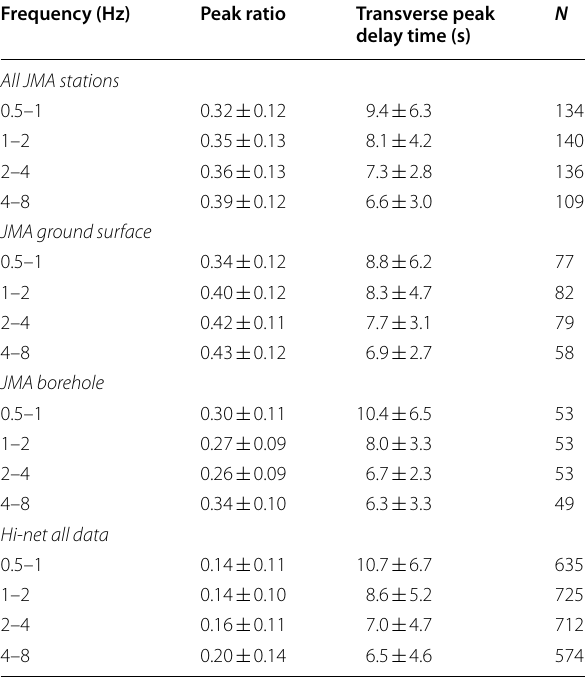
Table 1 Mean and standard deviation of peak amplitude ratios and transverse peak delay